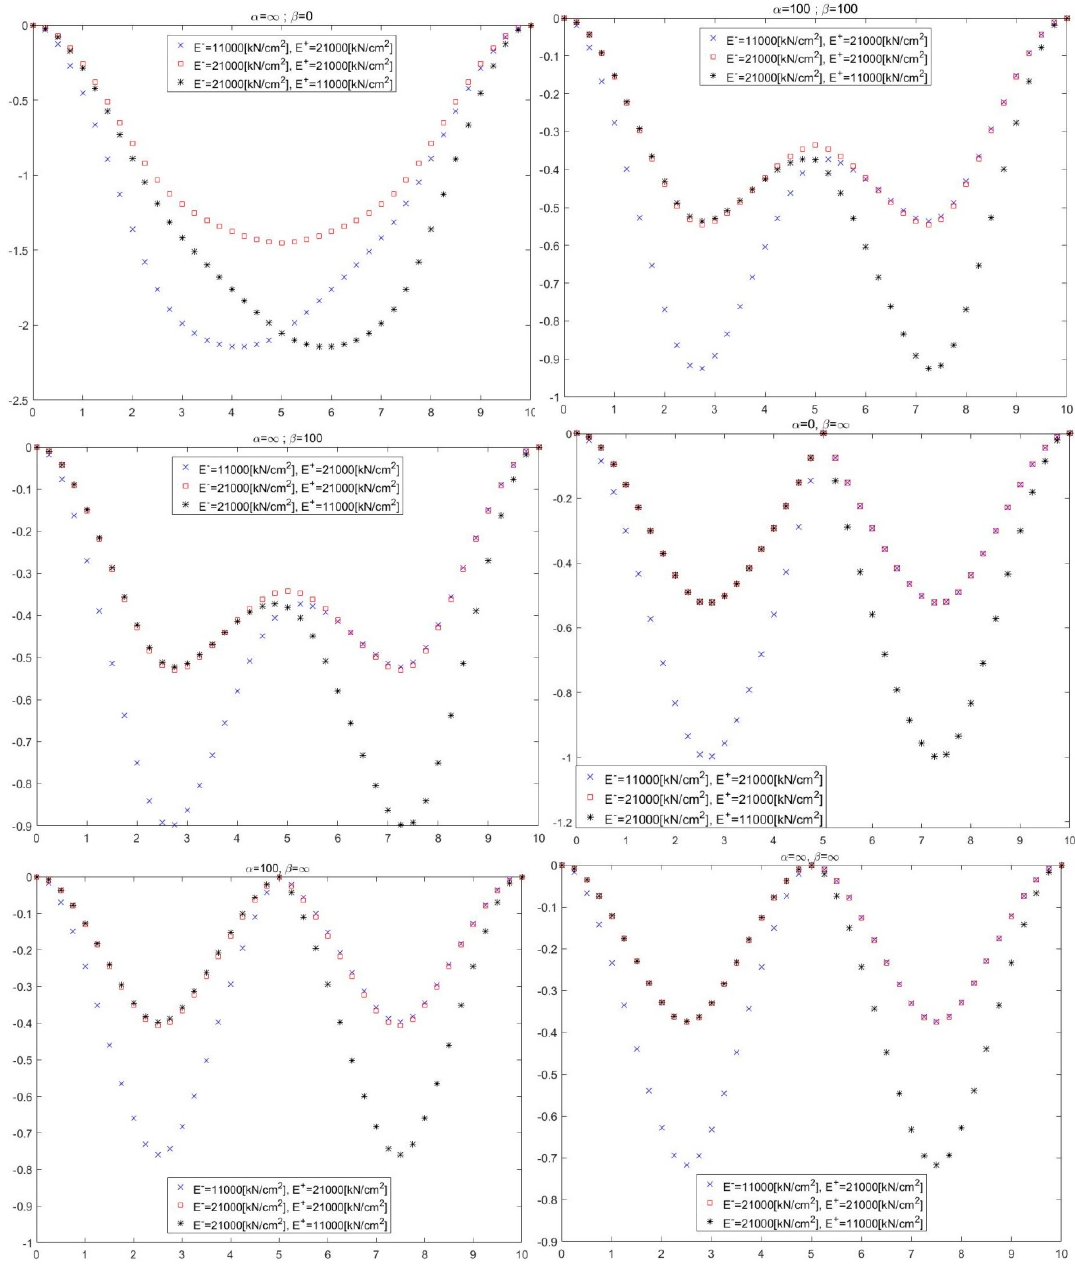
α and β . Figure 3. The cross sections for different values of α and β